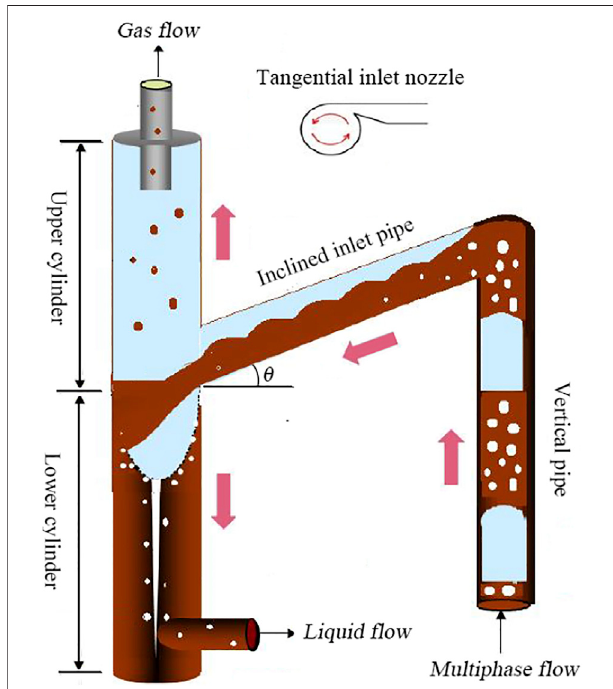
FIGURE 1 | Structure and operating principle of a